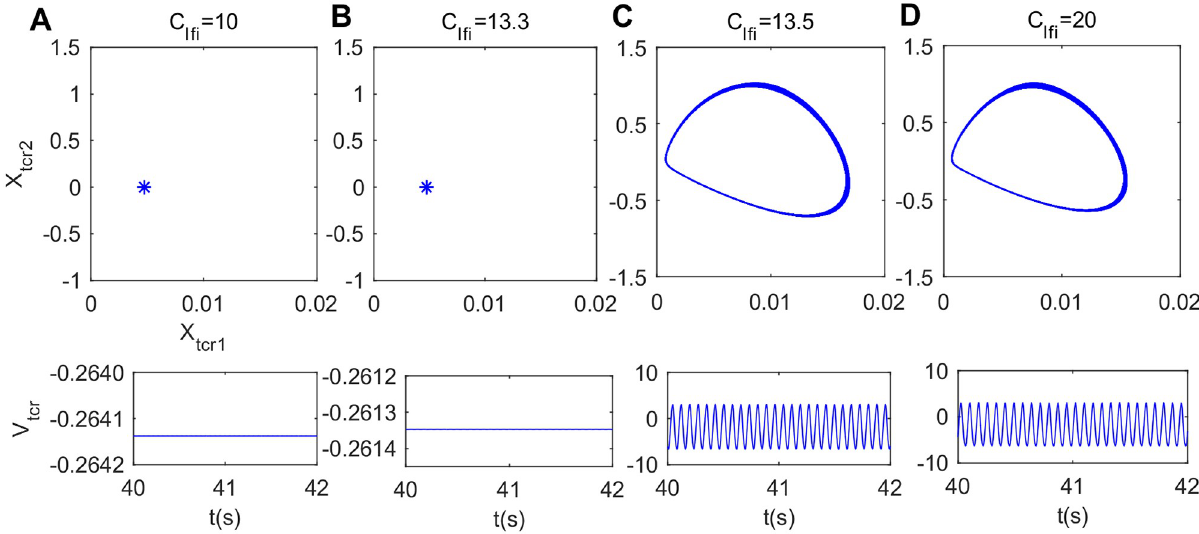
Fig 8. Phase plots (top panels) and the corresponding time series plots (bottom panels) of the thalamic module when C (A) C lfi = 10, (B) C lfi = 13.3, (C) C lfi = 13.5, (D) C lfi =